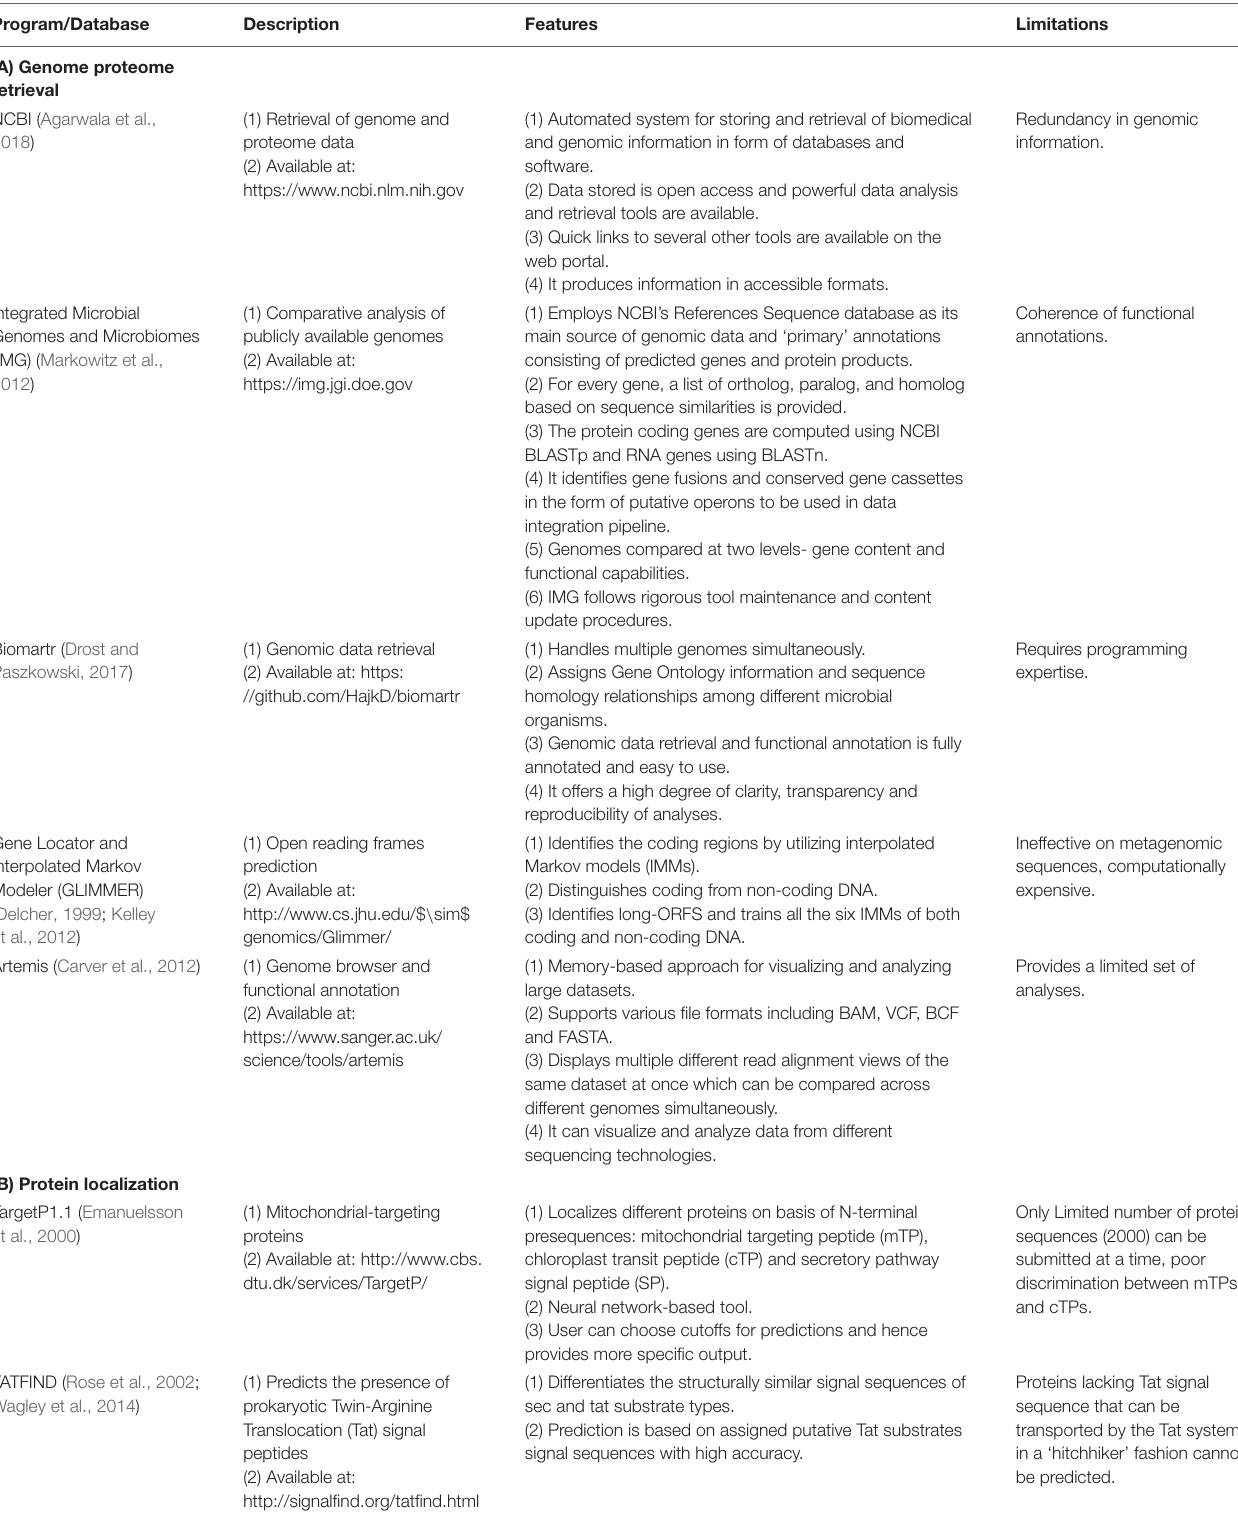
TABLE 3 | Commonly used software programs and databases for in silico approaches in antigen